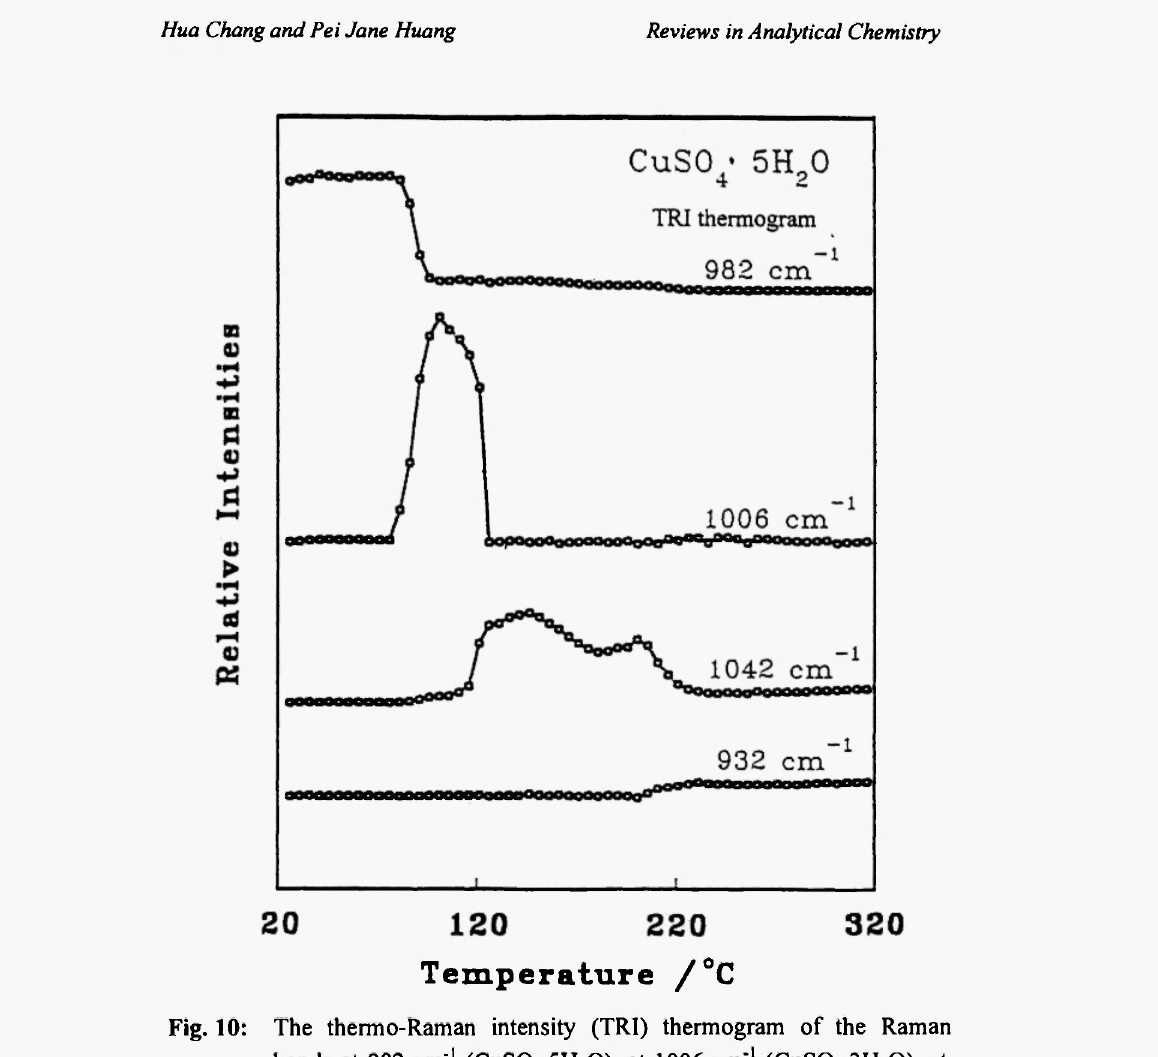
Fig. 10: The thermo-Raman intensity (TRI) thermogram of the Raman bands at 982 cm" 1 (CuS0 4 -5H 2 0), at 1006 cm" 1 (CuS0 4 -3H 2 0), at 1042 cm" 1 (CUS0 4 H 2 0) and at 932 cm' 1 (CuS0 4 ) in the dynamic thermal process (Ref. 15).